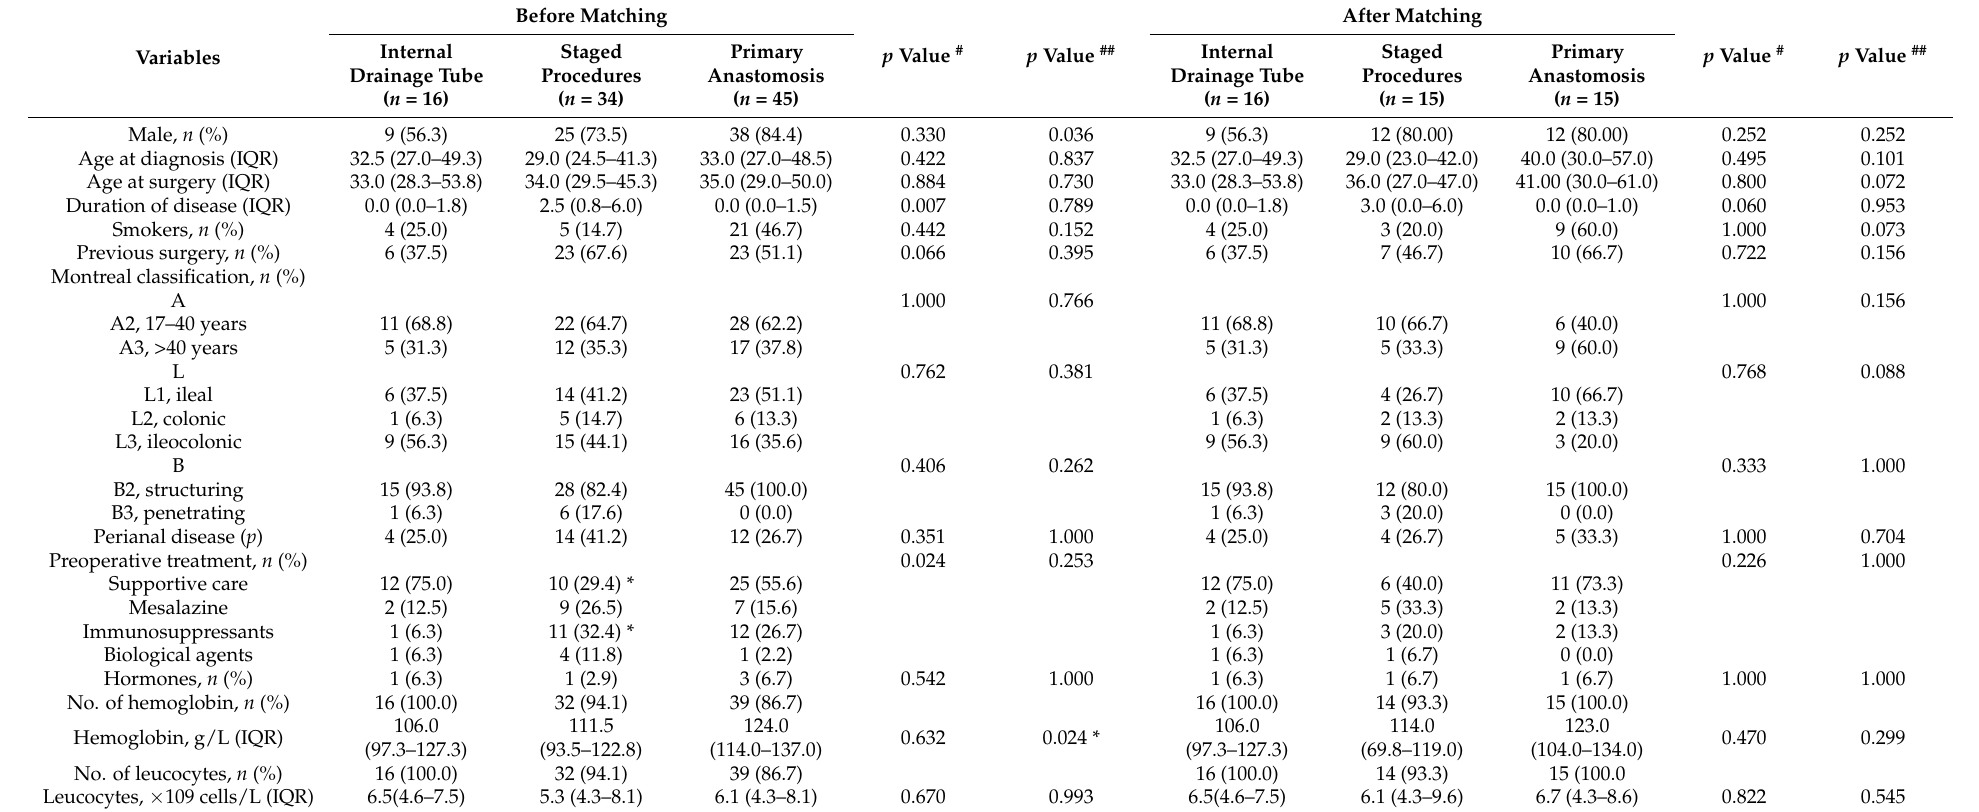
Table 3. Baseline characteristics of nonemergency patients before and after